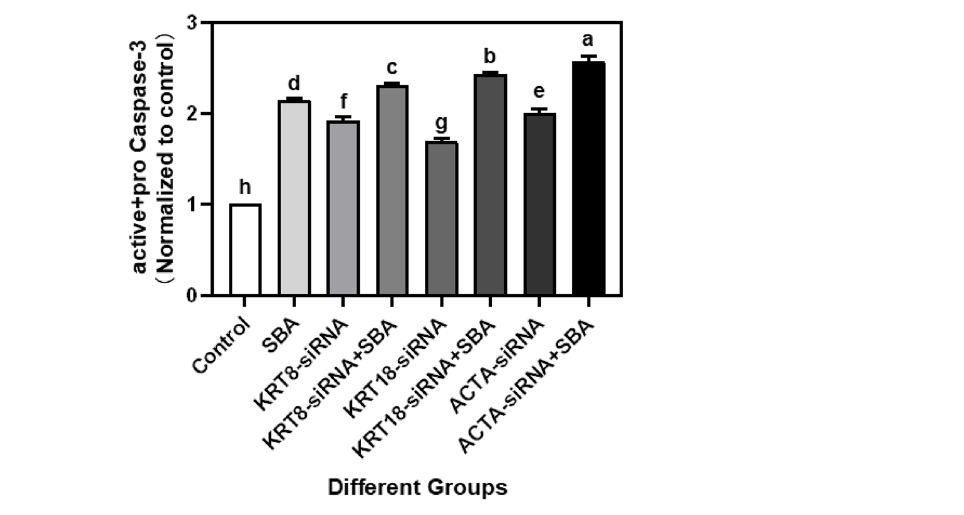
Figure 13. The determination of the protein expression of the p-caspase-3 in different treatments. The different treatments is Control treatment (T1); SBA treatment (T9); KRT8-siRNA treatment (T2); KRT8-siRNA + SBA treatment (T10); KRT18-siRNA treatment (T3); KRT18-siRNA + SBA treatment (T11); ACTA-siRNA treatment (T4); and ACTA-siRNA + SBA treatment (T12). Each column represents the mean ± SEM of three independent experiments. Different lowercase letters indicate the significance of differences between different treatment groups (p <